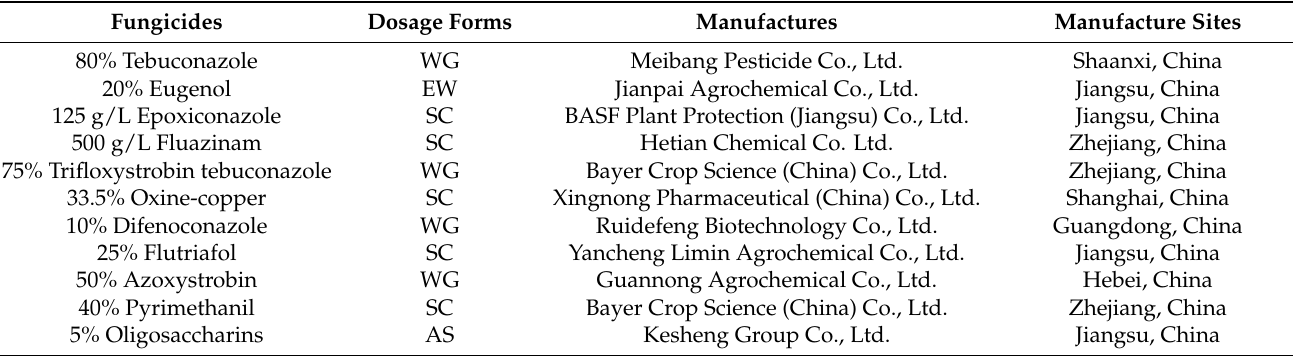
Table 1. The manufacturing information of tested fungicides.